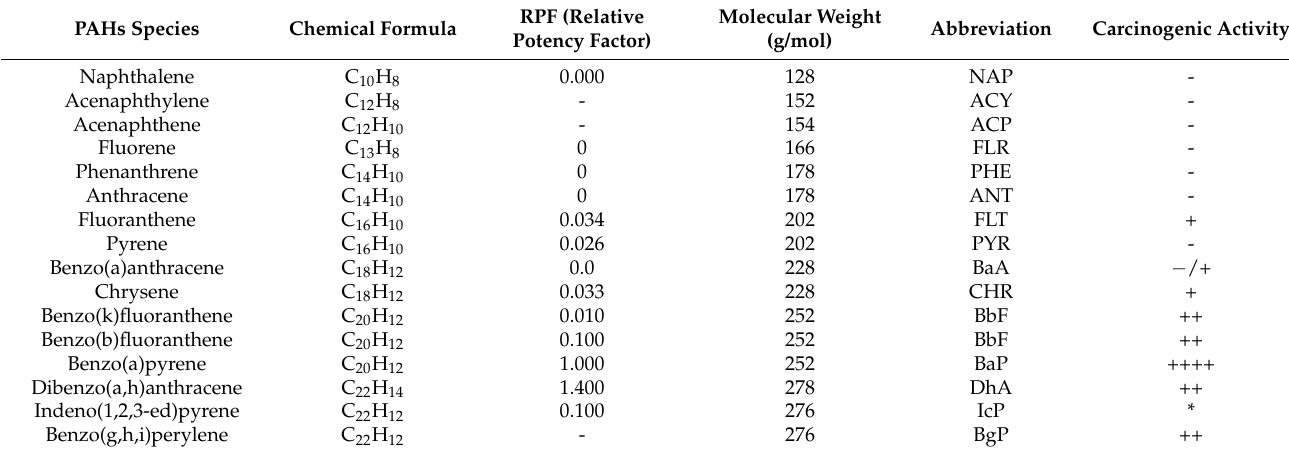
Table 5. Property of 16 PAHs proposed by EPA.